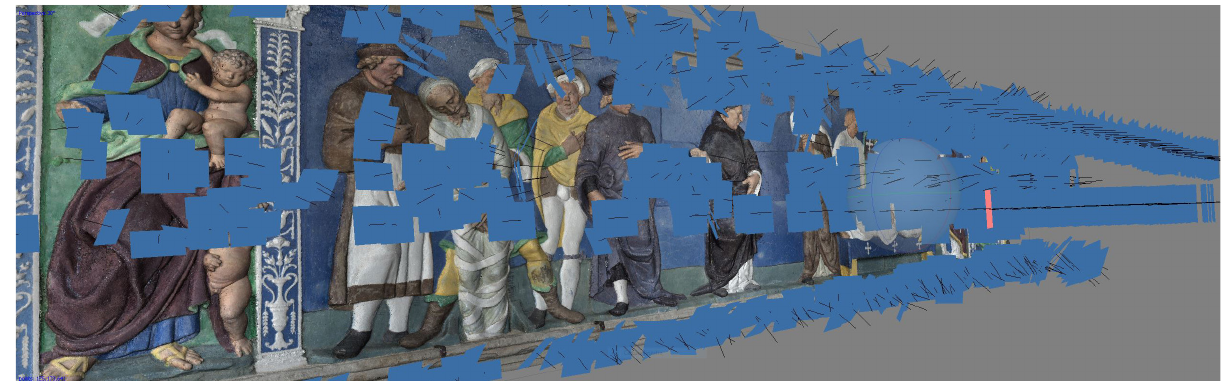
Figure 3. Camera network - post-restoration work photogrammetric